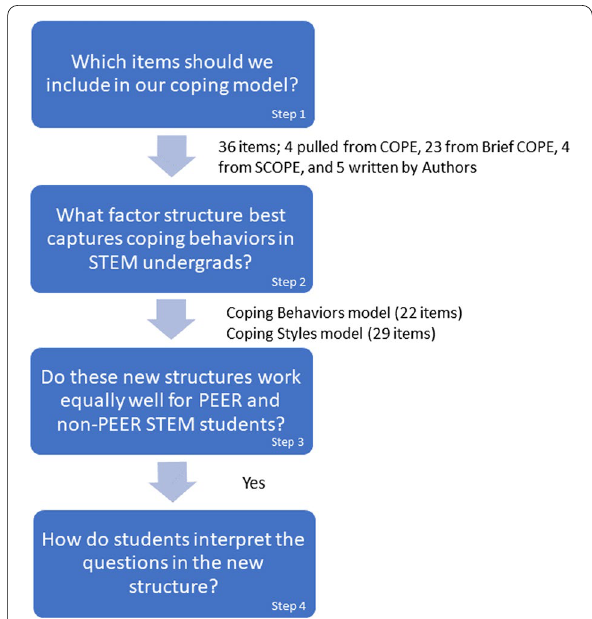
Fig. 1 Steps taken to evaluate the validity of the STEM